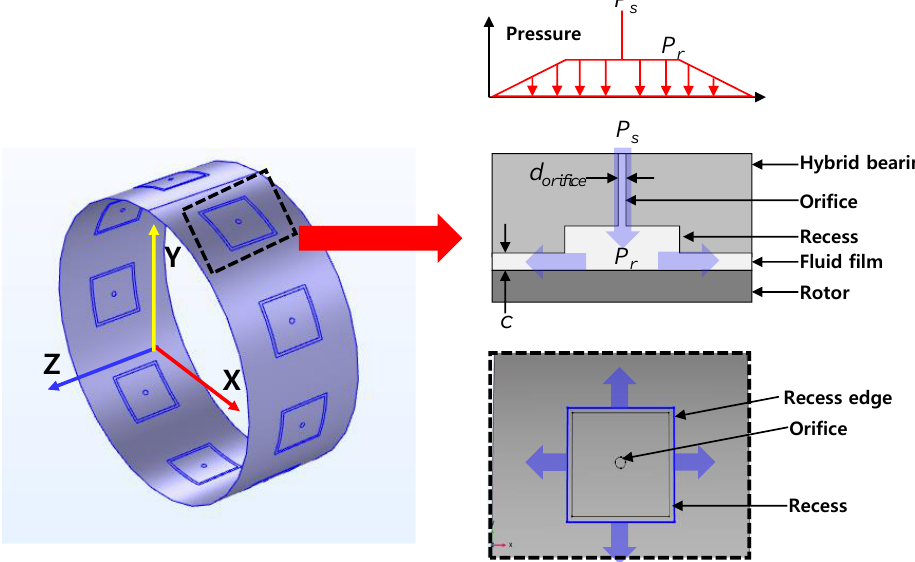
Figure 11. Hydrostatic bearing predictive model and flow path at recess.